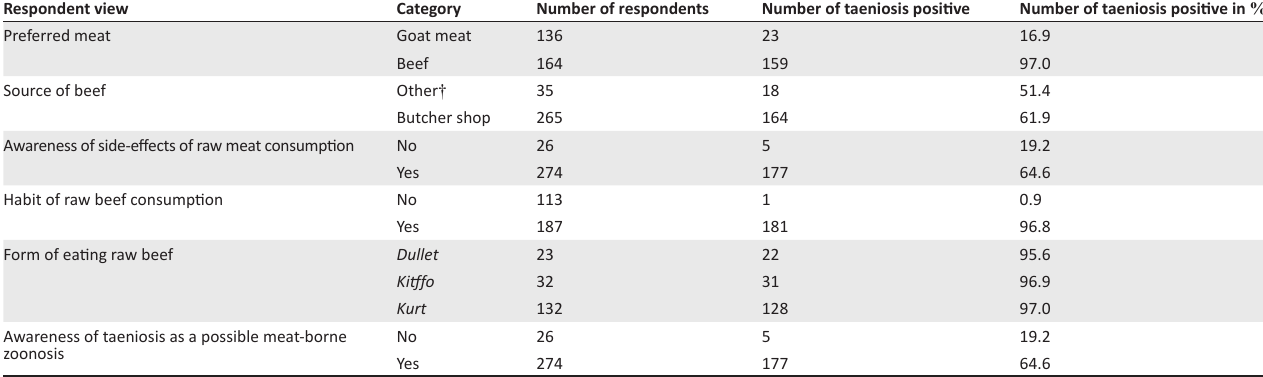
TABLE 5: Participant perception, knowledge, source and habit of beef consumption on Taenia saginata taeniosis. Respondent